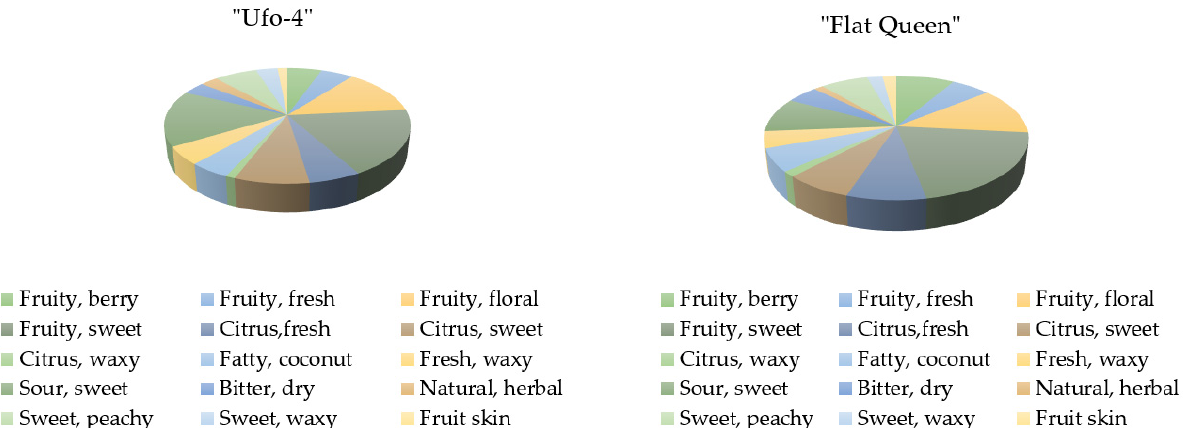
Figure 4. Flavor component distribution (%) in peach varieties.